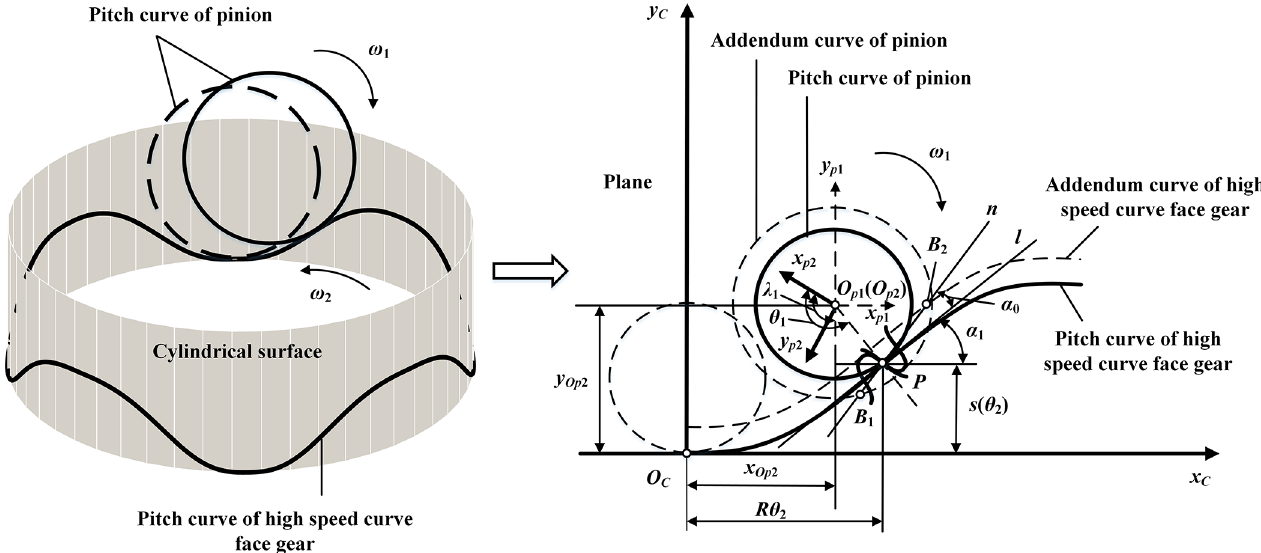
Fig. 7. Calculation of instantaneous contact